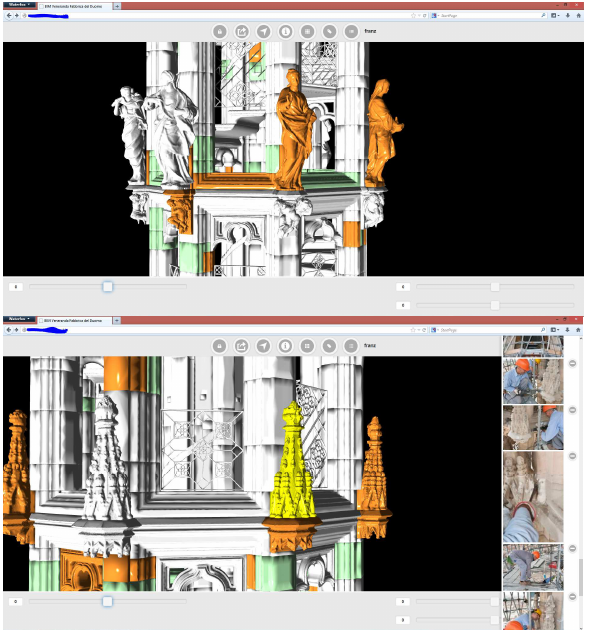
Figure 4. Web Viewer with the model loaded in LOD 1